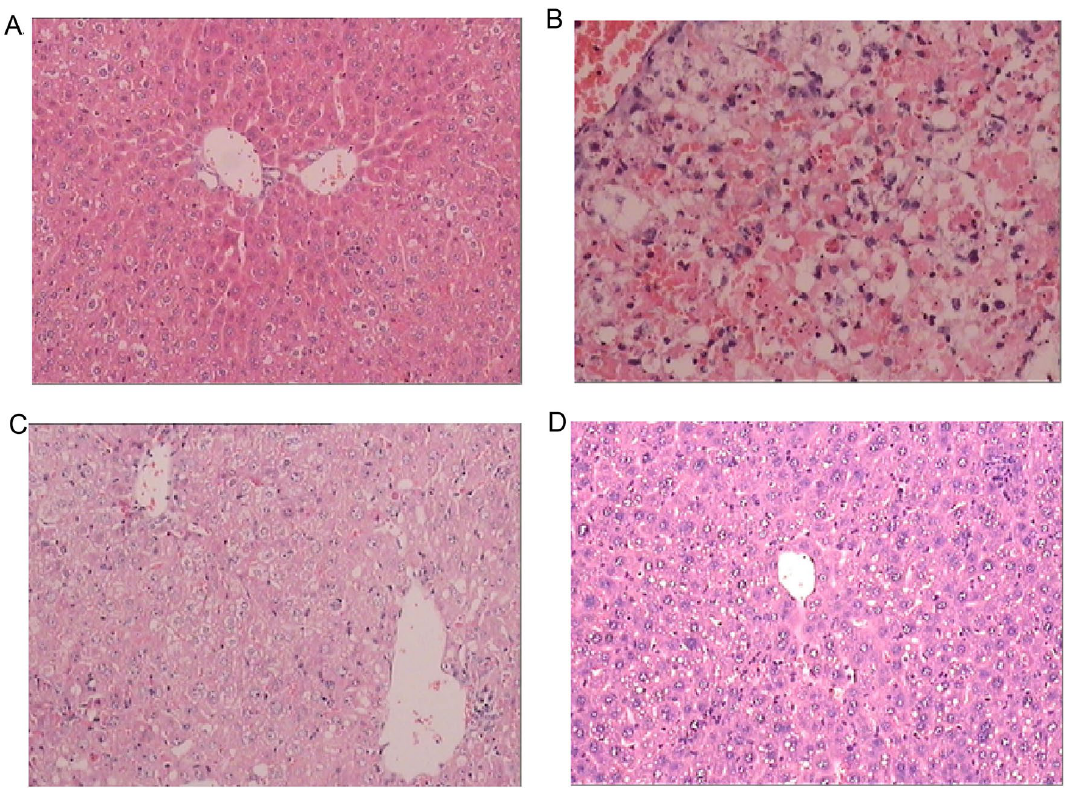
Figure 2. Microscopic examination of liver sections after FMT. ( A ) Histology of control group with abnormal liver architecture. ( B ) Histologically, d-GalN group showed obvious hemorrhage and inflammation, necrosis of hepatocytes, and severe dissolution of hepatocyte structure. ( C ) d-GalN-induced damage was partially restored in d-GalN + SS group. ( D ) Hepatic injury was markedly attenuated in d-GalN + SB